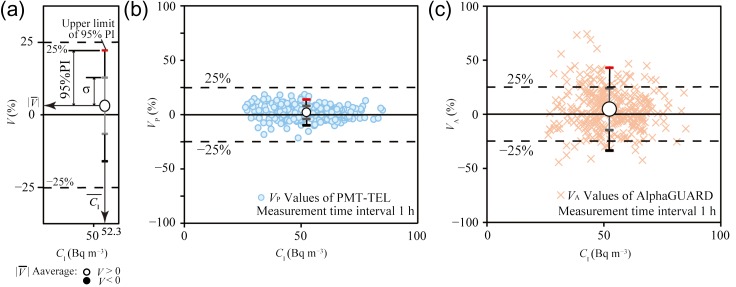
Evaluation of the range of the 95% PI of V¯% using integrated hourly data (n = 336). The relationship between the relative percent difference V% and the reference radon concentration (CI Bq m−3). (a) Explanation of symbols in Figures 3b and c, 4, 5 and 6; (b) The range of the 95% PIp of V¯P; (c) The range of the 95% PIA of V¯A.